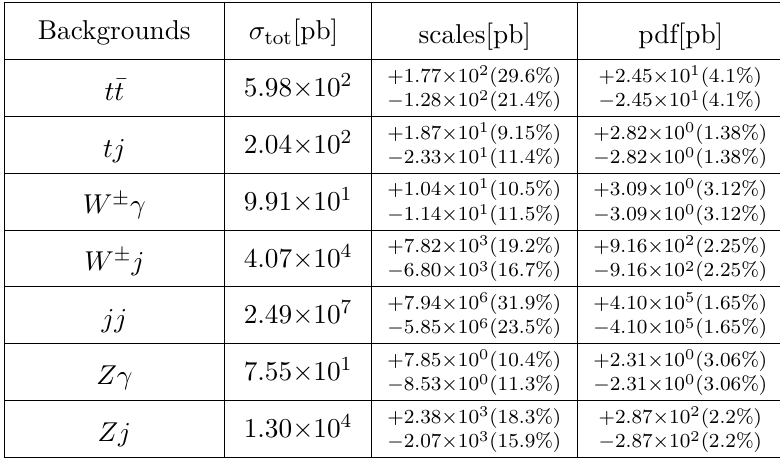
Table 1 . The fiducial cross sections of the SM backgrounds with the theoretical uncertainties at 14 TeV